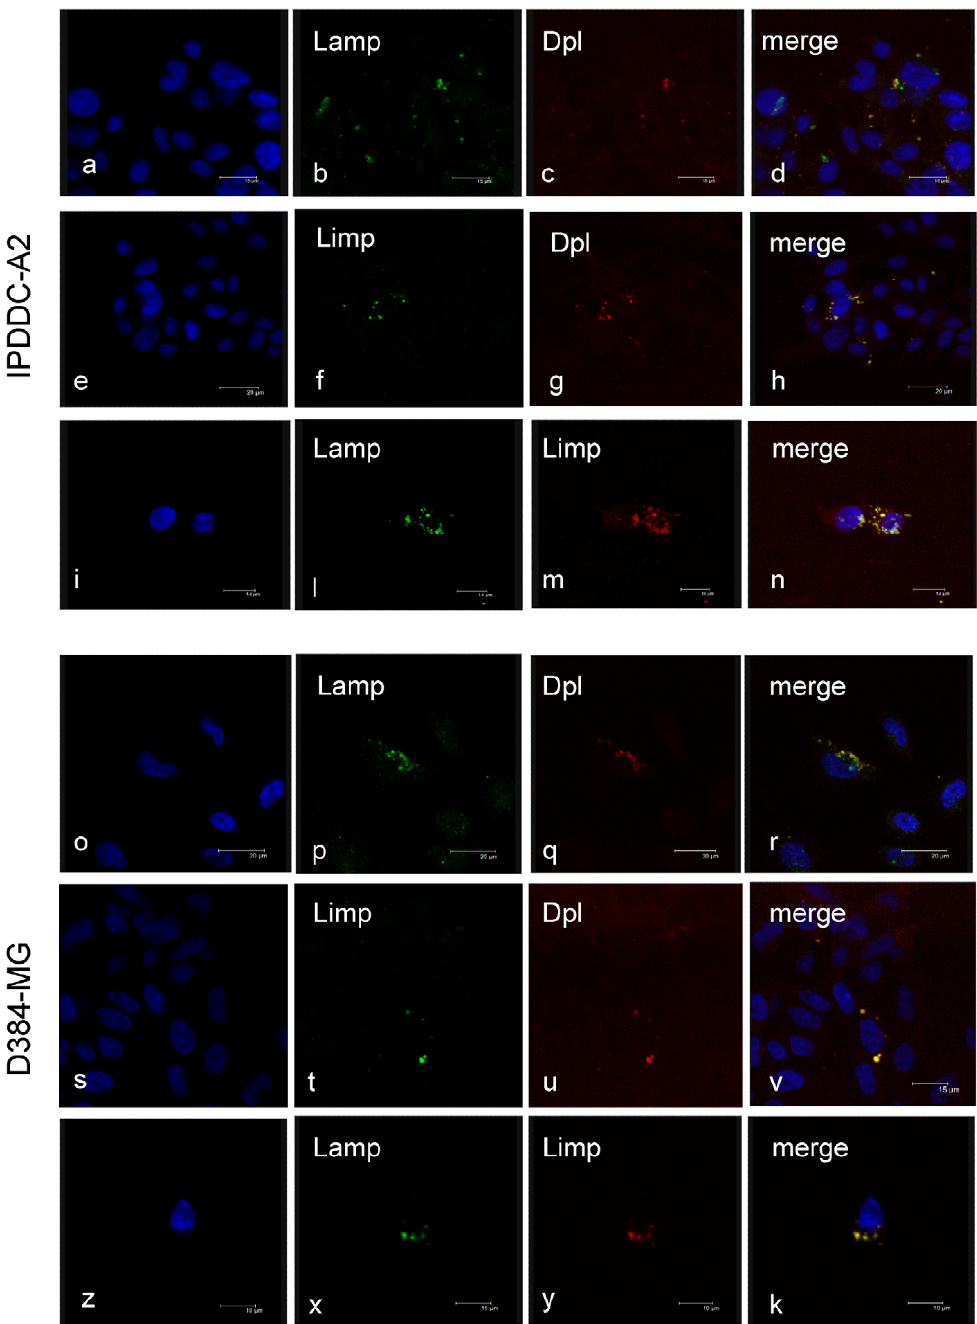
Fig. 1. Sub-cellular localization of Dpl in IPDDC-A2 and D384-MG astrocytoma cells. Cells were grown on glass slides as described in Materials and methods. At 48 hours, cells were fixed and incubated with primary antibodies, specifically mouse monoclonal Lamp-1 (Abcam) and G-20